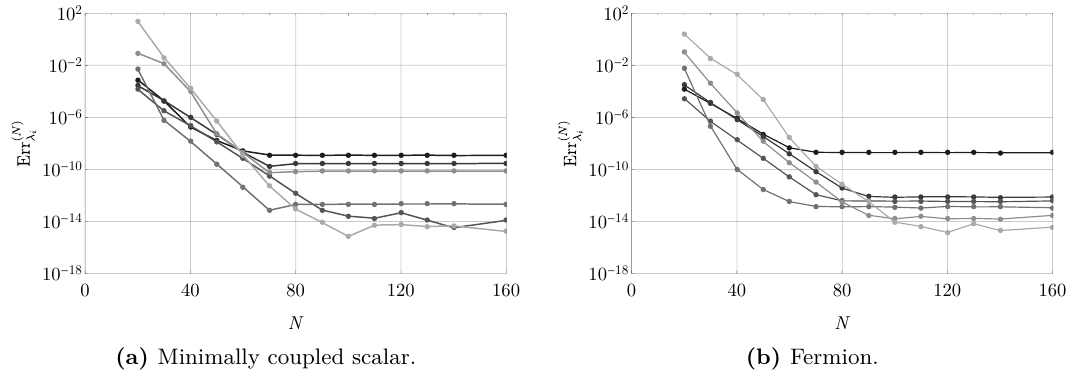
Figure 13. Plots of estimated fractional error (C.12) for the eigenvalues of L on the geometry given by the embedding (4.9) with ‘ = 3 and (cid:15)/(cid:15) max = 0 . 5 . From dark to light gray, each curve corresponds to the i th eigenvalue of L with i = 2 , 10 , 25 , 100 , 200 , 400